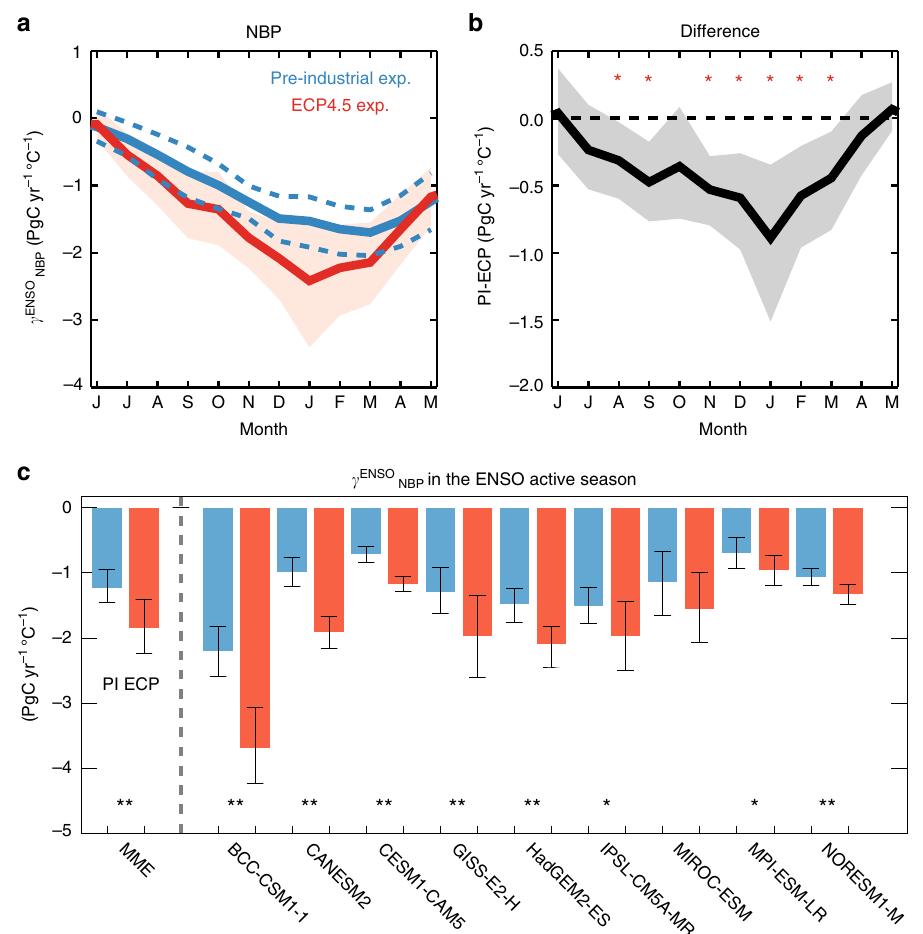
Fig. 1 Net biome production sensitivities to ENSO. a Regression coef fi cients of carbon- fl ux anomalies in the range 40 °S – 40 °N for the December – February (cid:1) (cid:3) (DJF) Nin ̃ o3.4 index for net biome production (NBP) γ ENSO based on the preindustrial experiment (blue) and ECP4.5 (red), and b the differences between (cid:1) (cid:3) NBP the two experiments Δ γ ENSO . Shaded area and dashed lines indicate 95% con fi dence levels calculated using the bootstrap method. Red stars indicate NBP signi fi cant months for Δ γ ENSO at 95% con fi dence levels. c Regression coef fi cients of NBP anomalies from September to February in the range 40 °S – 40 °N NBP for DJF Nin ̃ o3.4 for the preindustrial experiment and ECP4.5 based on multimodel ensemble (MME, left) as simple arithmetic mean of nine Earth System Models (ESMs) and individual ESMs (right). Error bars indicate 95% con fi dence levels of regression coef fi cients calculated by using bootstrap method. * P < 0.1 and ** P < 0.05 for difference between two experiments in regression coef fi cients being signi fi cantly different from